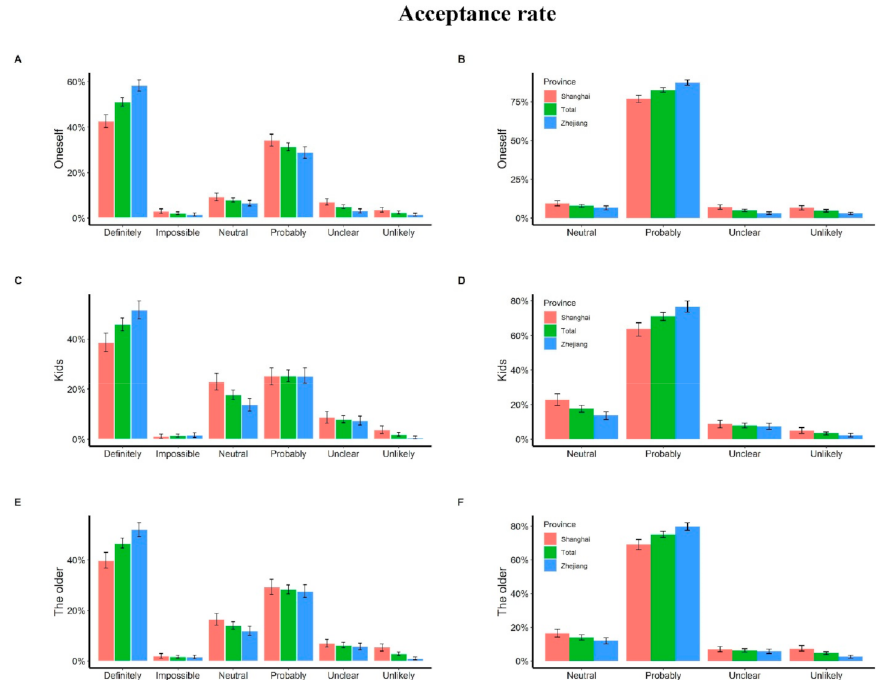
Figure 2. Vaccine acceptance of people in the community. ( A , B ) The acceptance rate of participants reported: ( C , D ) the willingness to vaccinate their kids; ( E , F ) the willingness to vaccinate the older in their family. For panel ( B , D , F ), we combined the options “definitely” and “probably” into probably, and combined “impossible” and “unlikely” into unlikely. For each plot, the read bar represents the acceptance rate of Shanghai, the blue bar represents the acceptance rate of Zhejiang, and the green bar represents the overall acceptance rat, the tentacles on the bars represent averaged results of bootstrap simulations with 95% confidence